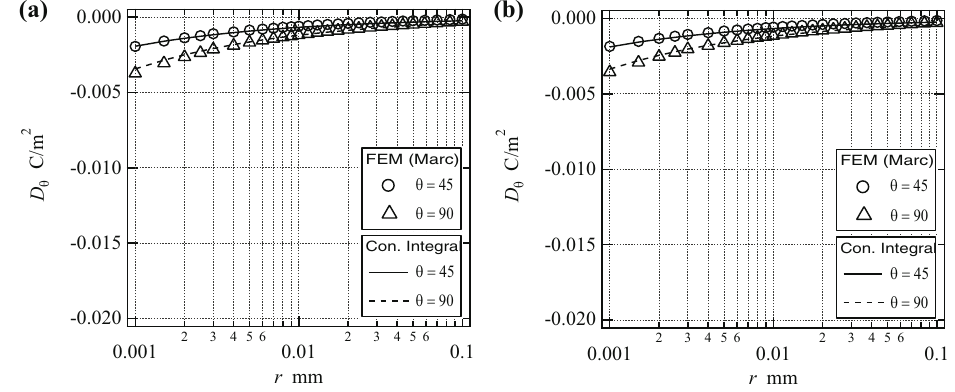
Figure 13: Distribution of electricdisplacements, D θ , at ϕ = 90° and θ = 45° and 90° with respect to r onthe singular line ( front - line at d = 3 mm ) : ( a ) Model - 1 and ( b ) Model -